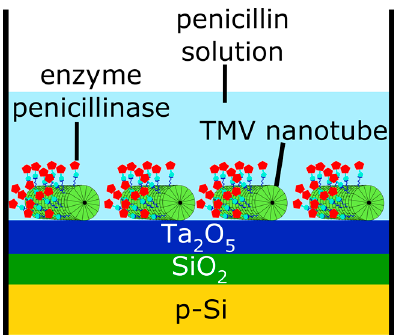
Figure 1. Schematic layer structure of the field-effect penicillin biosensor modified with TMV nanotubes as enzyme (penicillinase)